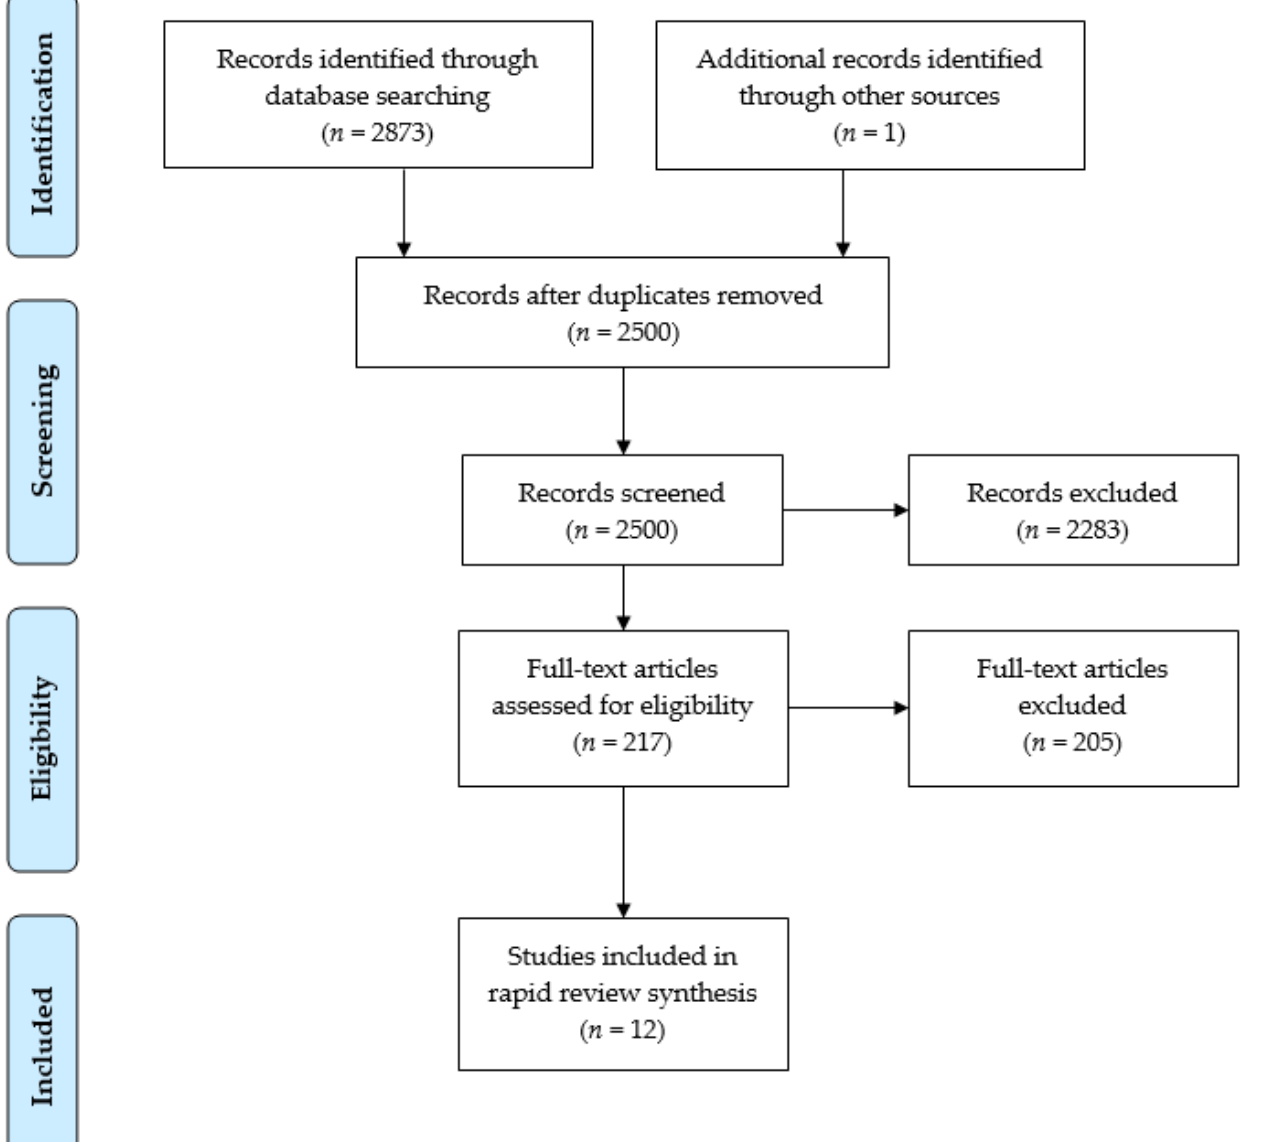
Figure 1. The preferred reporting items for systematic reviews and meta-analysis for RQ1. Adapted from Moher et al. (2009) [17].